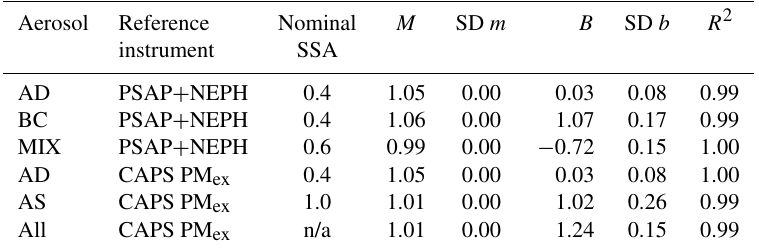
Figure 5. Comparison result (mean value and standard deviation for each level) of the extinction channel of the CAPS PM SSA with the CAPS PM ex and the combination PSAP + NEPH for the different aerosol types (dashed line is the identity line, i.e., 1 : 1 line). Table 7. Linear-regression parameters obtained by fitting 10s averaged data including the slope ( M ), standard deviation of the slope (SD m ), intercept ( B ), standard deviation of intercept (SD b ) and linear-regression coefficient ( R 2 ) for the comparison of the CAPS PM SSA extinction channel with proven